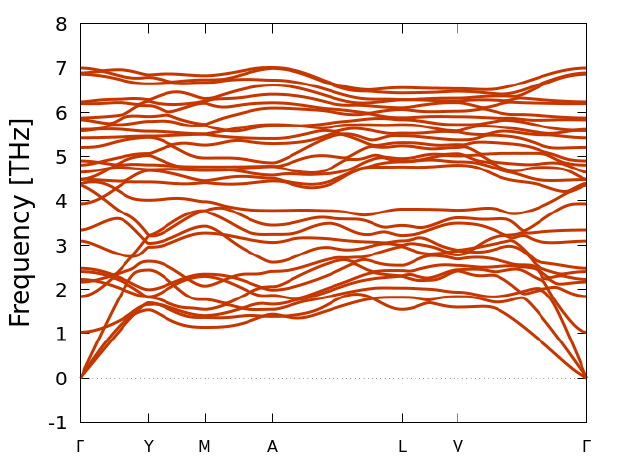
Figure 3. Harmonic phonon dispersion curves of the C2/m phase of the Sb 2 Se 3 compound at 20